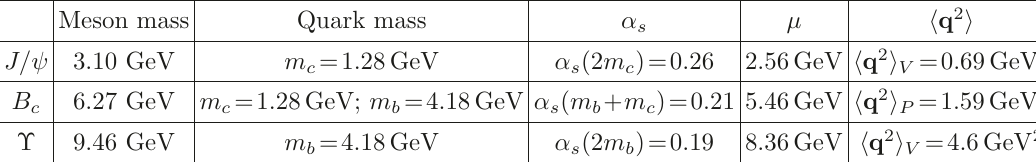
Table 2 . Input parameters.